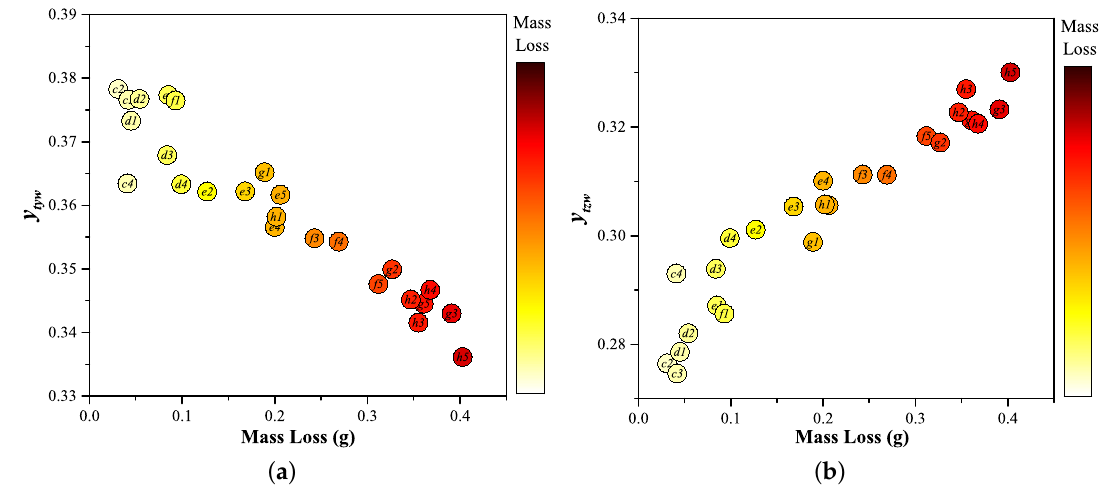
Figure 11. Secondary chromatic parameters as a function of mass loss. ( a ) y tyw ; and ( b ) y tzw .